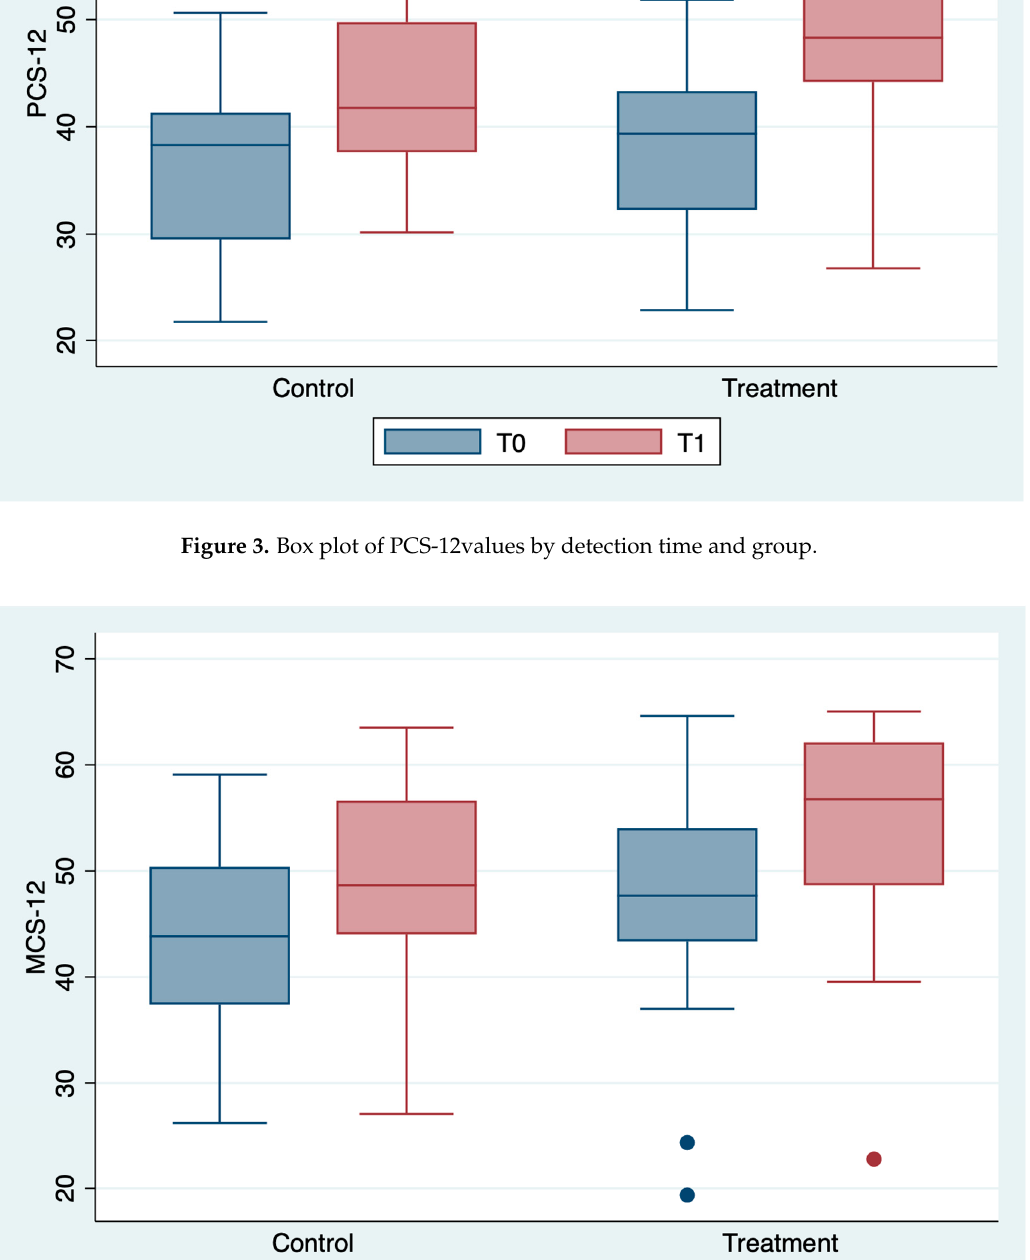
Figure 4. Box plot of MCS ‐ 12 values by detection time and group.